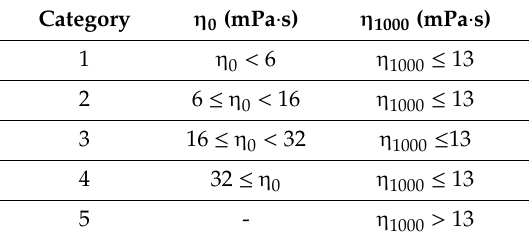
Table 3. Proposed categorization of HA eye drops based on their flow